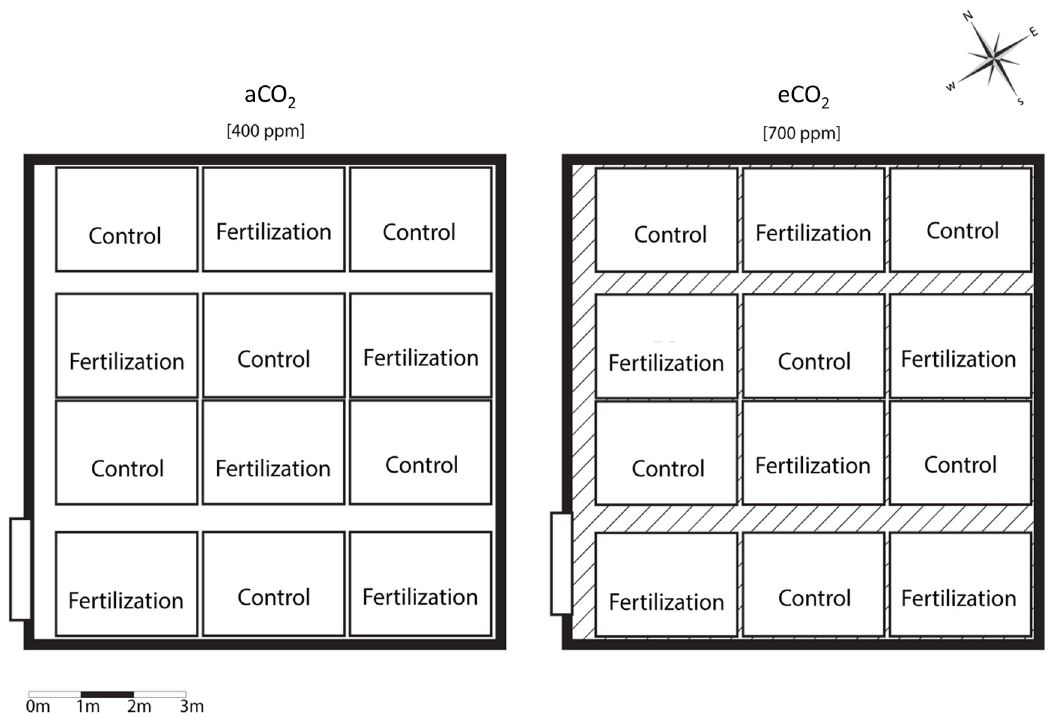
Fig 1. Experimental design scheme. aCO 2 —ambient CO 2 concentration, eCO 2 —elevated CO 2 concentration, Control—plots without nutrient supply, Fertilization—plots with nutrient supply.